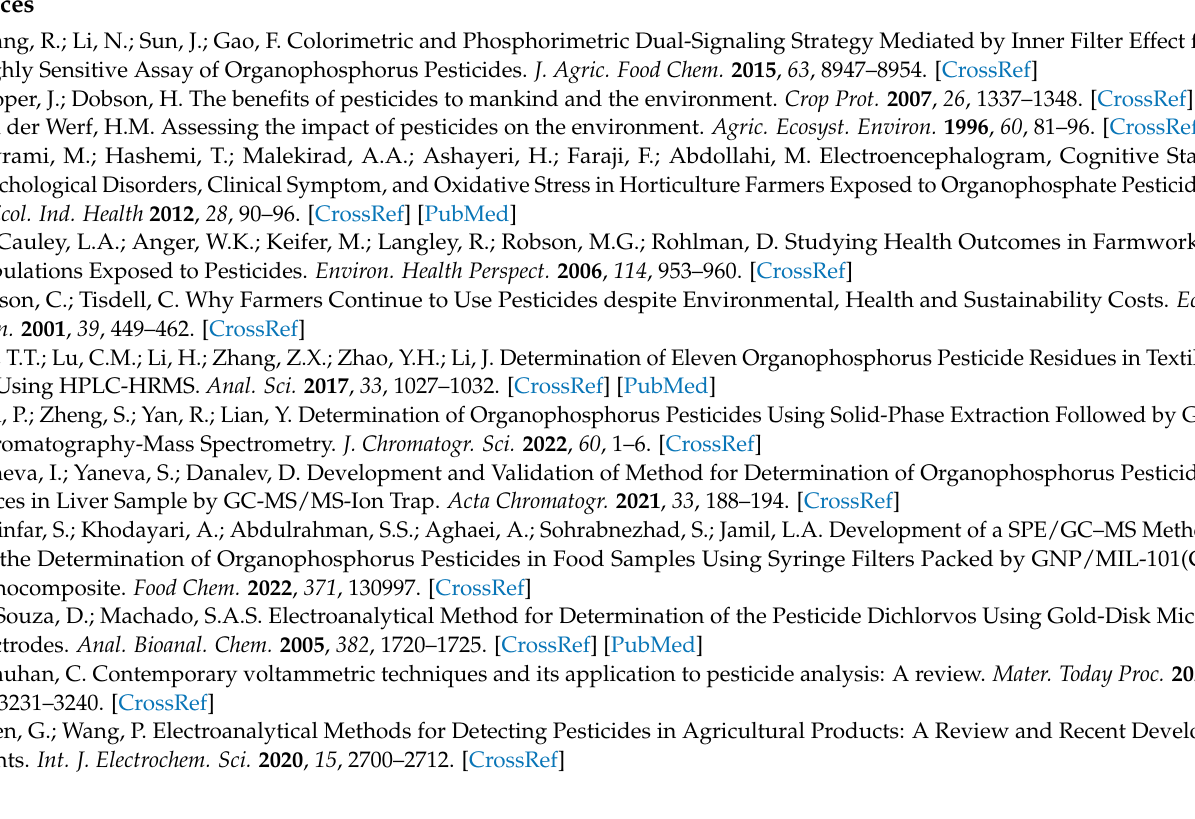
temperature, Figure S3: The luminescence intensity ratio of the Eu (III)–(vitB1) 2 complex at two wavelengths (616/592 nm) vs. 1/[P] in methanol at λ ex = 268 nm, at room temperature), Table S1: The apparent binding constants (log K) of the Eu(III)–(vitB1) 2 complex with chlorfenvinphos and malathion pesticides, using ratiometric analysis by measuring fluorescence intensity at the emission wavelengths of 616 and 592 nm, in methanol, and at room